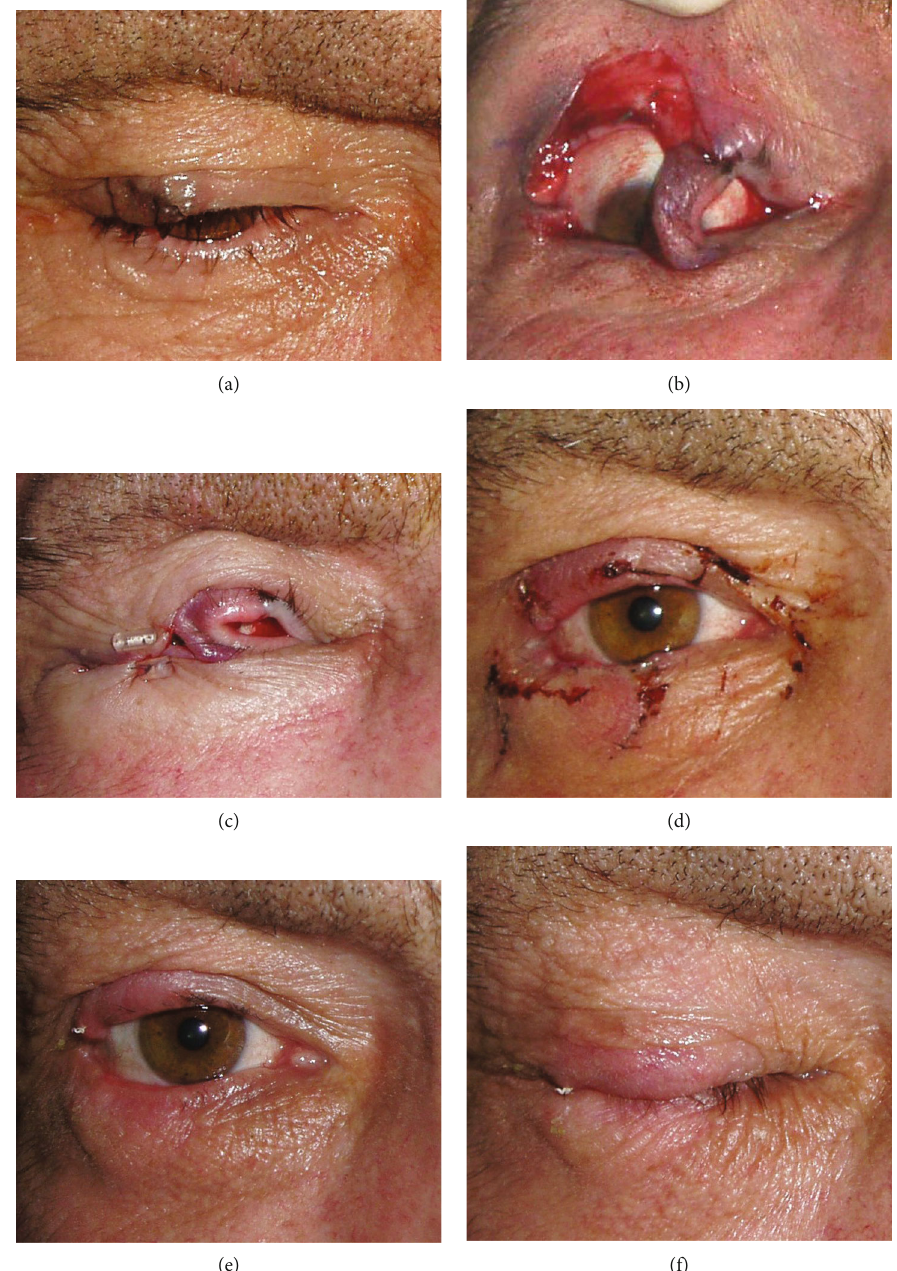
Figure 1: (a) A large nodular tumor with telangiectatic surface vessels involving the lateral half of the right upper lid. (b) The fl ap with a nasally oriented vascular pedicle. (c) The bolster of the lateral temporary tarsorrhaphy in place. (d) The reconstruction of the lower lid at the second stage of the procedure. (e) A satisfactory cosmetic appearance of both lids. (f) The full lid